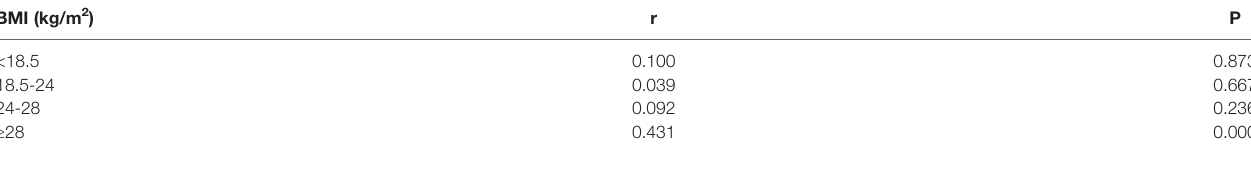
TABLE 7 | Relationship between serum 25(OH)D and total testosterone after BMI strati fi cation. BMI (kg/m 2 ) r P <18.5